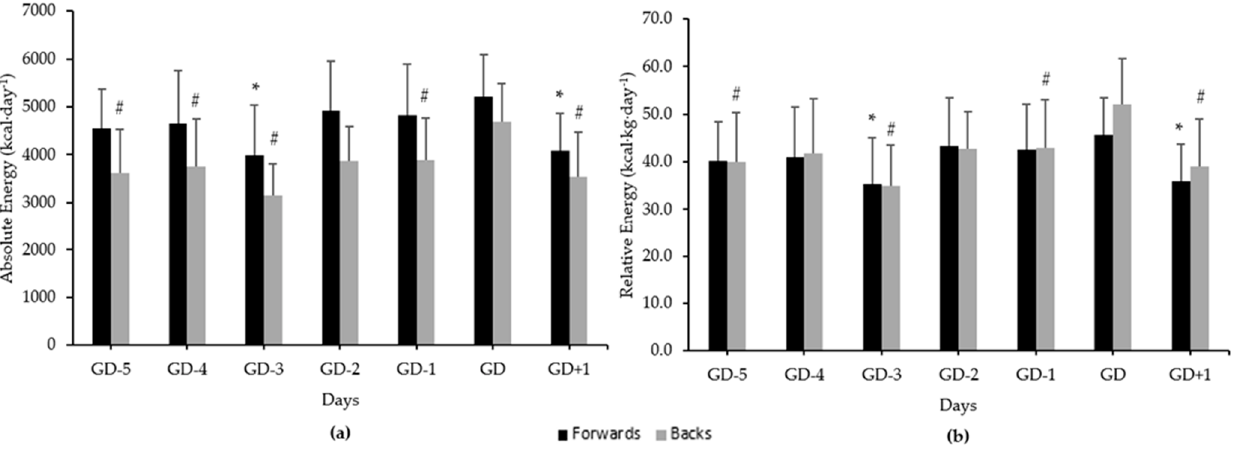
Figure 1. Mean daily energy intakes across a seven-day competition week (GD-5, -4, -3, -2, -1, GD, GD+1) among forwards and backs. ( a ) Absolute energy intake; ( b ) relative energy intake. Error bars represent standard deviation. * Indicates a significant difference to GD for forwards ( p < 0.05). # Indicates a significant difference to GD for backs ( p < 0.05).